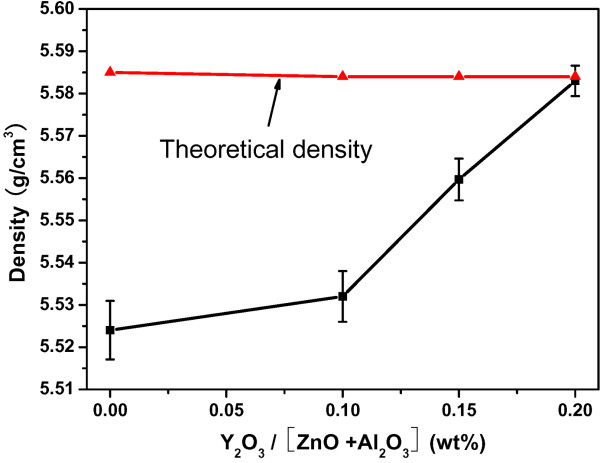
 The measured densities and the theoretical densities. The measured densities and the TDs as a function of Y2O3 concentrations.